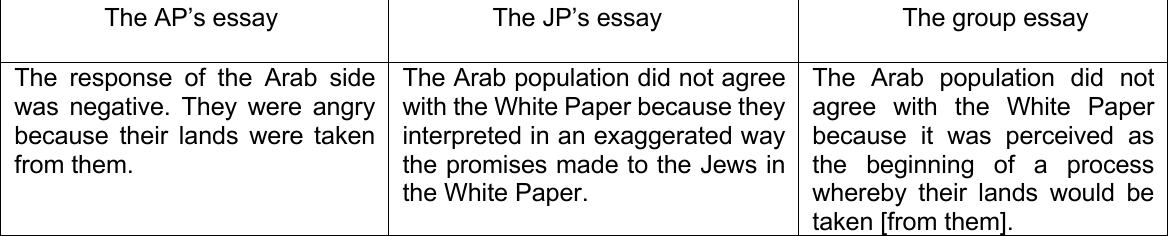
Table 1. The response of the Arab historical agent to the issuance of the White paper in